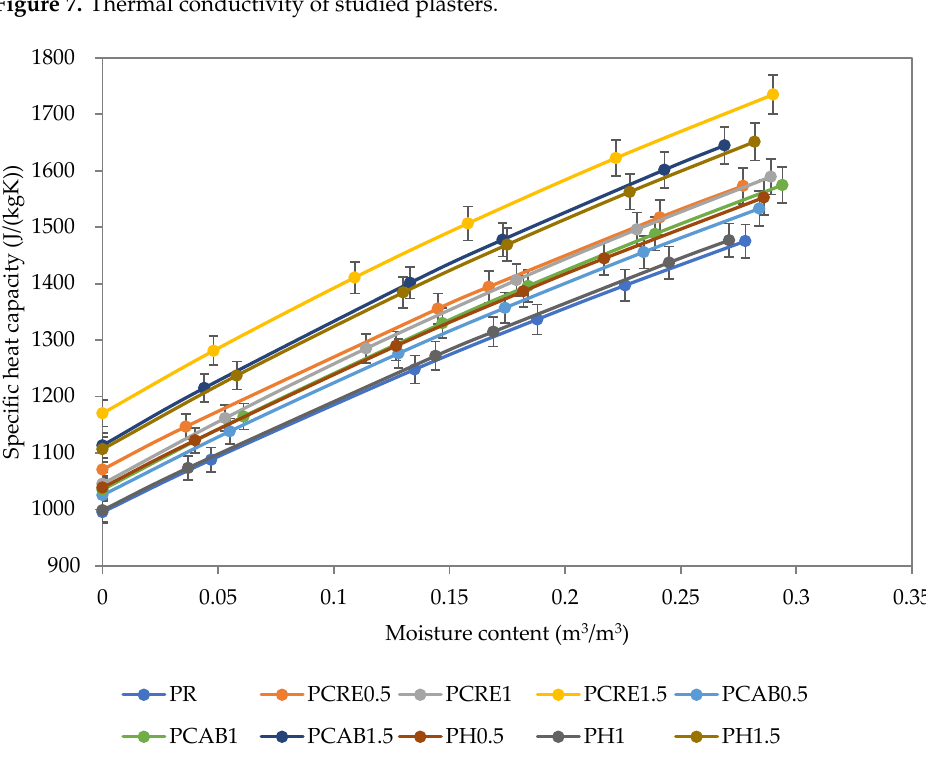
Figure 8. Specific heat capacity of studied plasters.